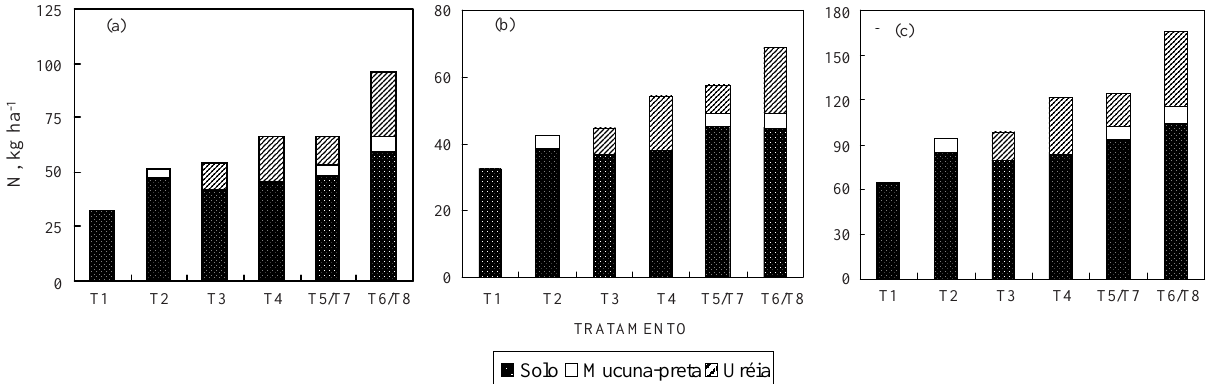
Figura 1. Contribuições do solo, adubo verde e fertilizante mineral para o N acumulado no colmo e folhas (a); espiga (b) e parte aérea (c) das plantas de milho, em amostragem realizada 85 dias após